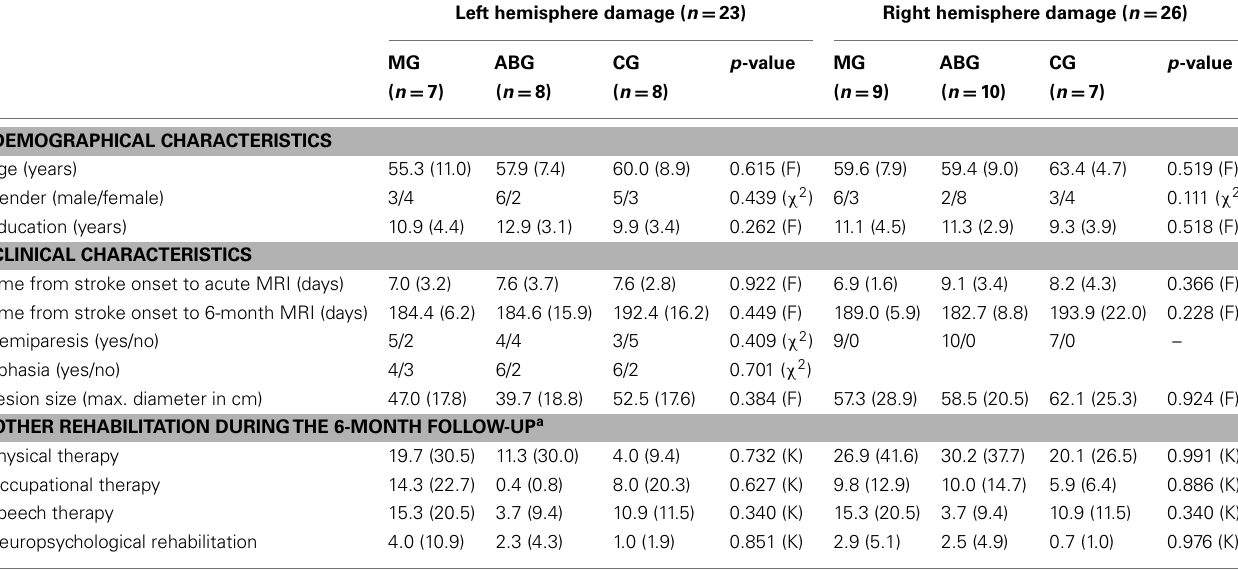
Table 1 | Demographic and clinical characteristics of the patients ( n =